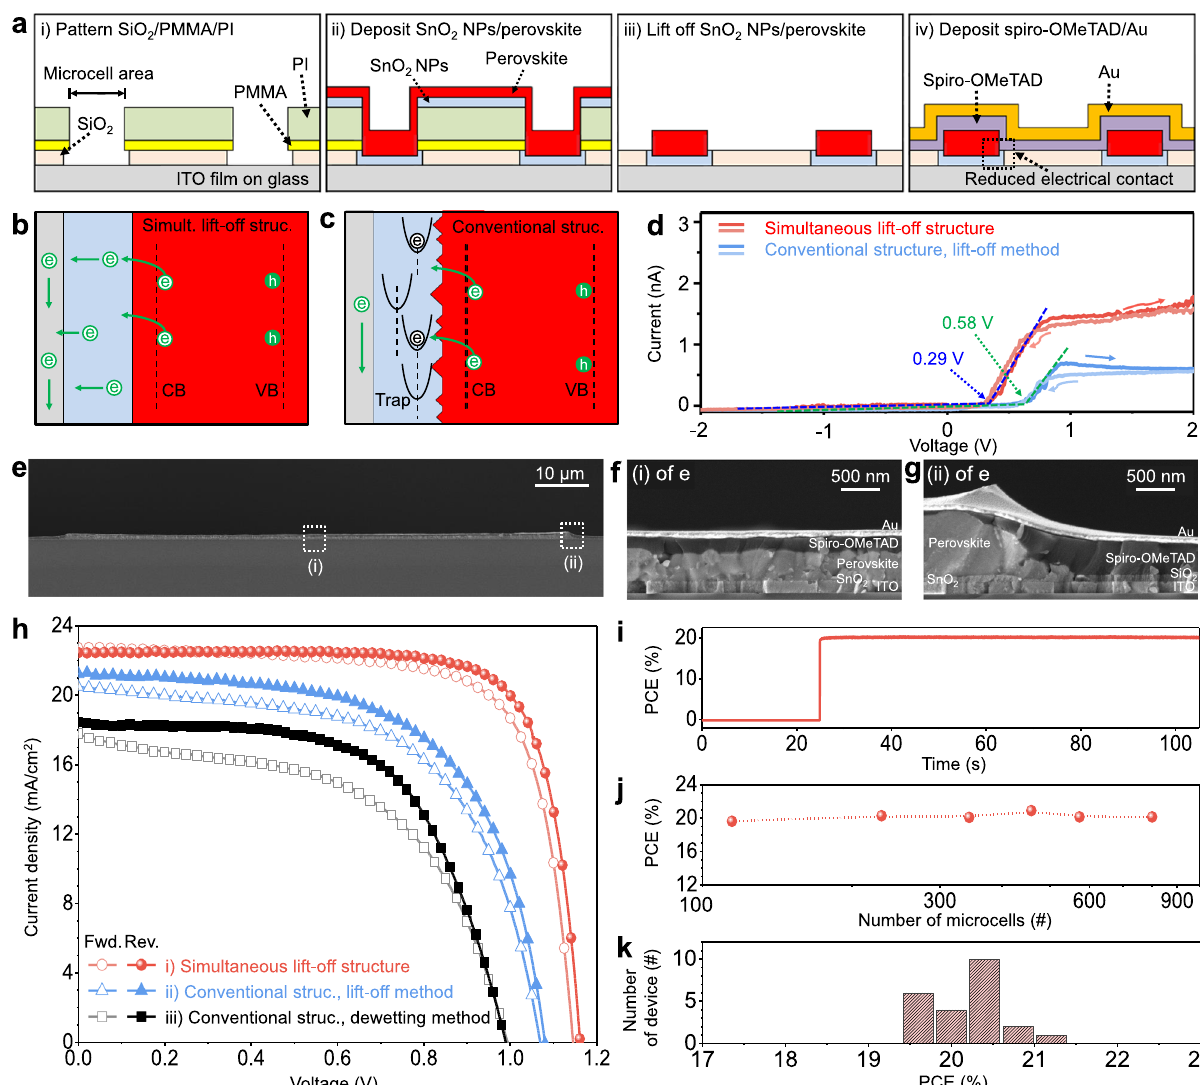
Fig. 3 Perovskite microcells with reduced interfacial defects. a Cross-sectional illustrations of the fabrication process of perovskite microcells. b , c Schematic illustrations of the charge-carrier dynamics in the perovskite microcell with the simultaneous lift-off structure ( b ) and the conventional structure ( c ). d Current – voltage ( I – V ) characteristics of the ETL/perovskite layer with the simultaneous lift-off structure (red) and the conventional structure (blue) in the dark condition. Pointed values and arrows indicate threshold voltages and scan directions, respectively. e Cross-sectional SEM image of a perovskite microcell. f , g Magni fi ed view of Fig. 3e at the center ( f ) and at the edge ( g ). h Current density – voltage ( J – V ) characteristics of three types of patterned devices under the forward and reverse scan. i Stabilized power output of perovskite microcells. j PCEs (reverse scan) depending on the number of perovskite microcells in the PV. k Statistical data on the PCE of 25 PVs (reverse